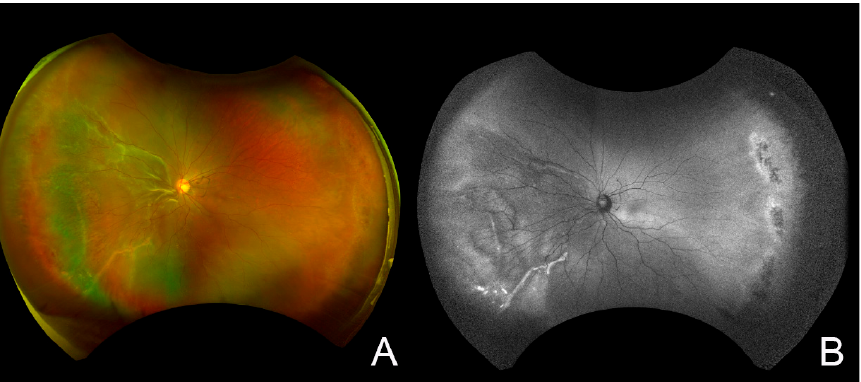
Figure 2. Preoperative widefield fundus photograph and fundus autofluorescence (FAF) image of the left eye. ( A ): The widefield fundus photograph shows the retinal detachment in the nasal and inferior quadrants adjacent to the macula. It is associated with an atrophic hole in the inferonasal quadrants and lattice degeneration in the temporal quadrants. ( B ): FAF image shows a hypo-FAF area corresponding to retinal detachment and hyper-FAF lesions corresponding to the subretinal fibrosis, but no peripapillary starfish hypo-FAF was observed in the eye with retinal angioid streaks. Because of the fragility of the eye due to mcEDS, minimal surgery was planned with minimal deformation of the eyeball. Before the scleral buckling surgery, retinal photo- coagulation was performed for the lattice degeneration at the temporal quadrant without an RRD to reduce the area needing the scleral buckle. Then, the scleral buckling surgery was performed for the RRD under local anesthesia. The surgery was begun by placing 3.0